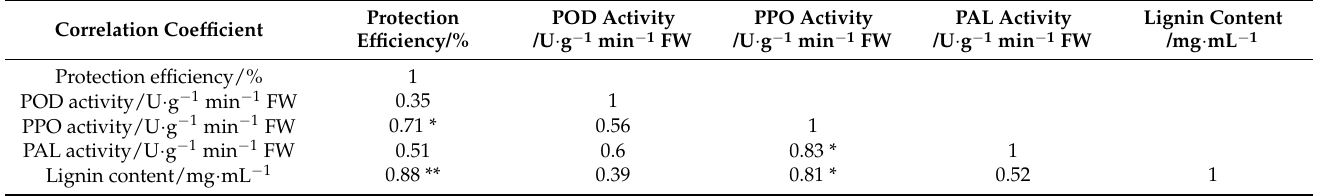
Table 1. Correlation coefficient between phenolic components in kiwifruit stems and protection efficiency. Correlation